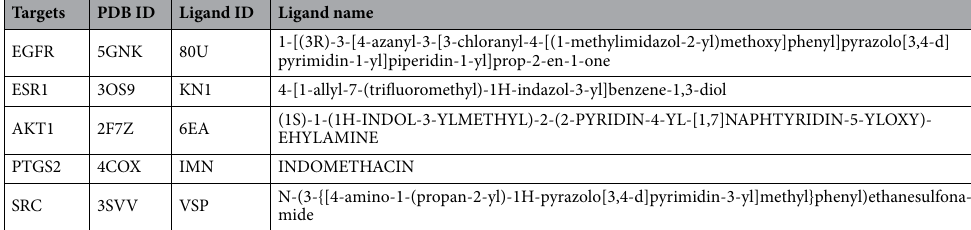
Table 3. The basic information of ligand and